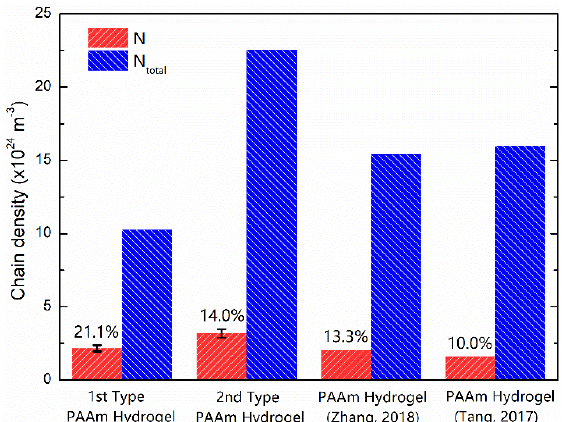
Figure 4. Extracted chain density vs. estimated chain density for three types of PAAm hydrogels.